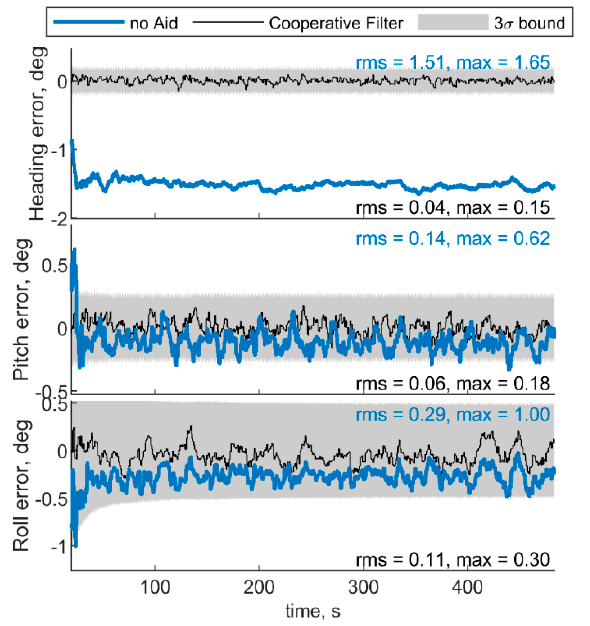
Figure 8. Errors on angle estimated by the cooperative filter in blue and by the same filter without using cooperation. Chief trajectory is in reported in Figure 3. Two deputies, r = 100 m, μ = 0°, Δχ = 20°. When µ increases up to 90 ◦ , cooperative measurements have more impact on the horizontal plane angles (pitch and roll) than on heading. Results obtained using Δχ = 70°